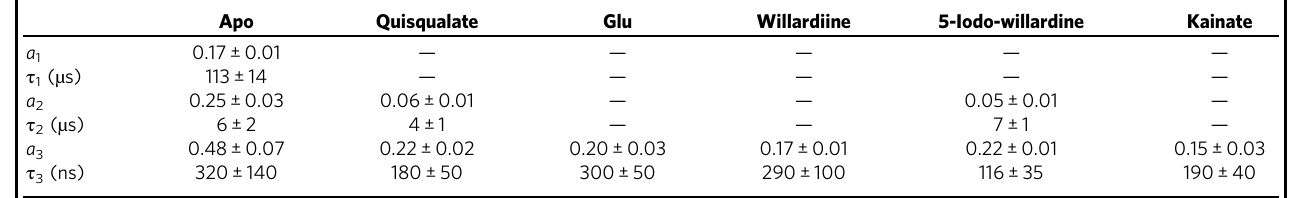
Table 1 Kinetics of sub-ms clamshell motions of GluA2-LBD-G446C-T685W in presence of partial and full agonists.